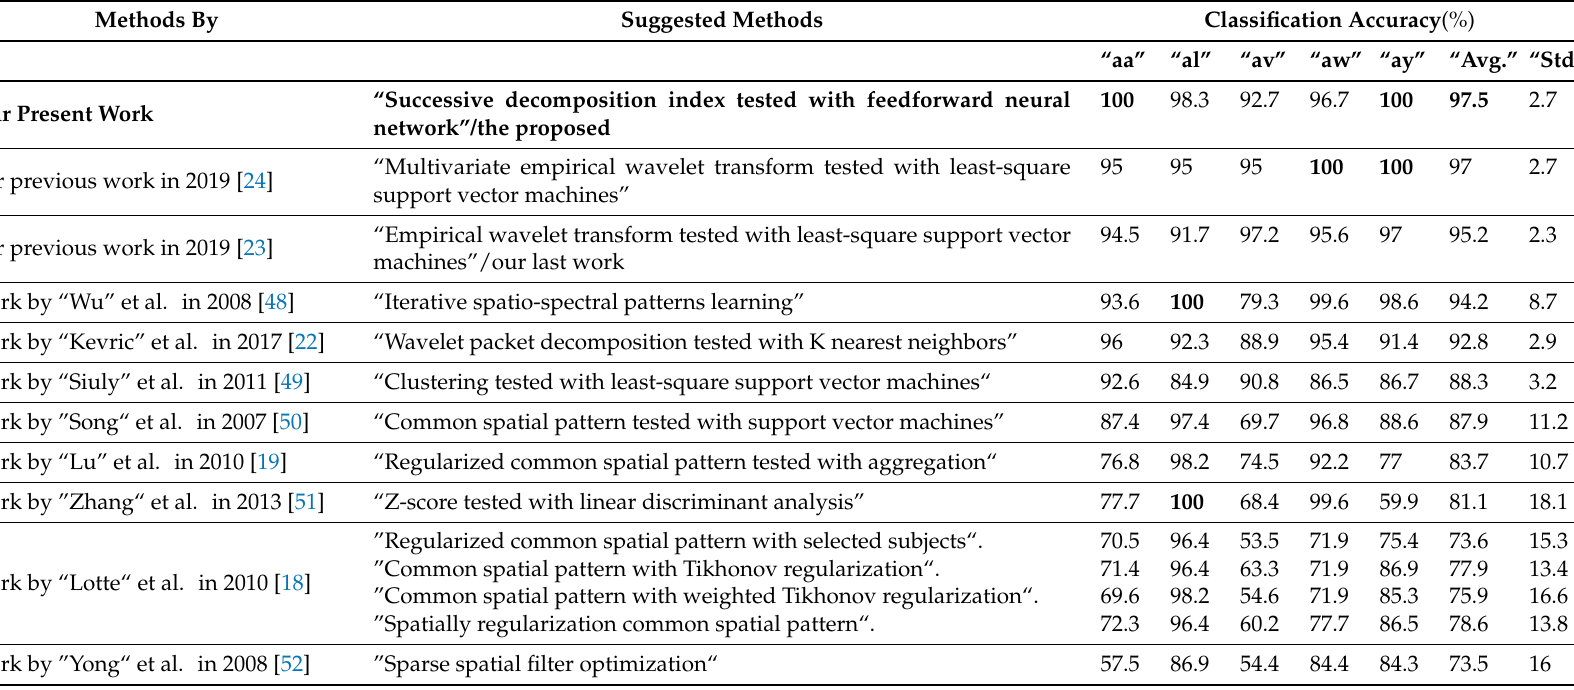
Table 7. Performance comparison of motor imagery EEG signals in terms of classification accuracy (%) with other